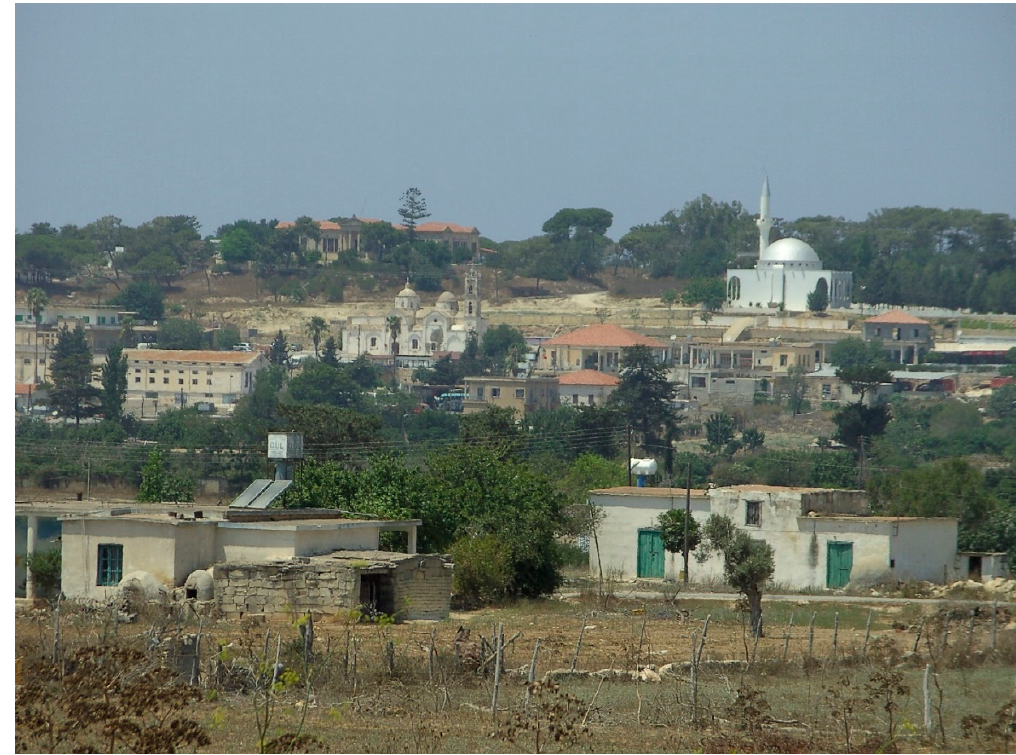
Figure 7. Dipkarpaz/Rizokarpaso, view from south-east. Top-right, the mosque of 1991 (modern type) with its mihrab in the center. Top-left, the church of St. Synesios (photo: authors).